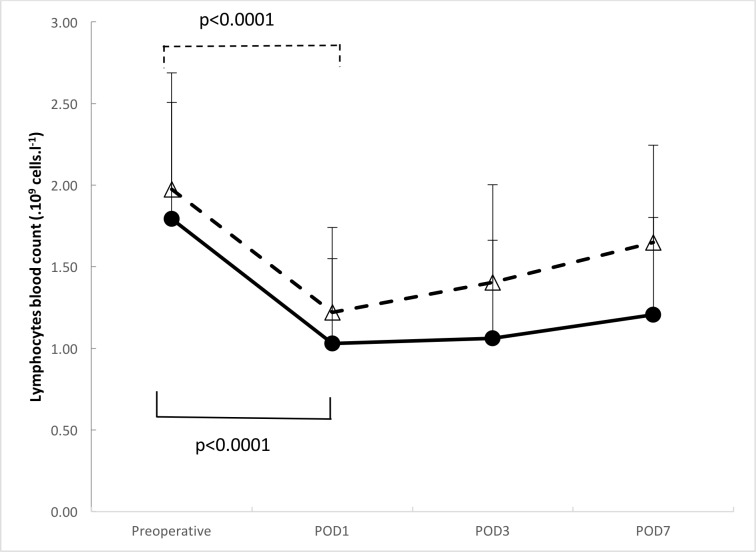
Changes of lymphocyte blood count.Black line with black circles shows patients’ lymphocyte counts with postoperative pneumonia. The dotted line with white triangles shows patients’ lymphocyte count with no postoperative pneumonia.